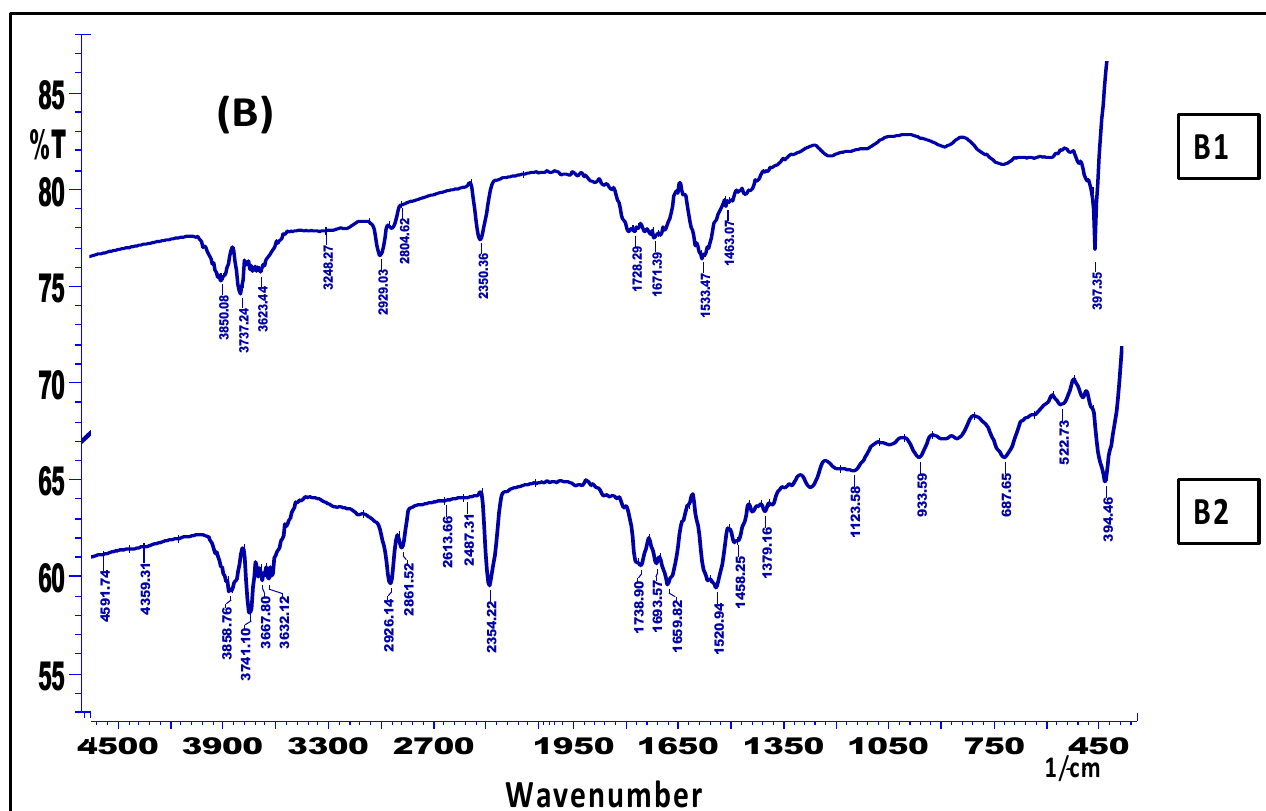
Figure 3. ( A ) DSC thermogram of mice skin. (A1) Untreated, (A2) Treated with optimized FTQ-NEG. ( B ) FTIR spectra of mice skin. (B1) Untreated, (B2) Treated with optimized FTQ-NEG.